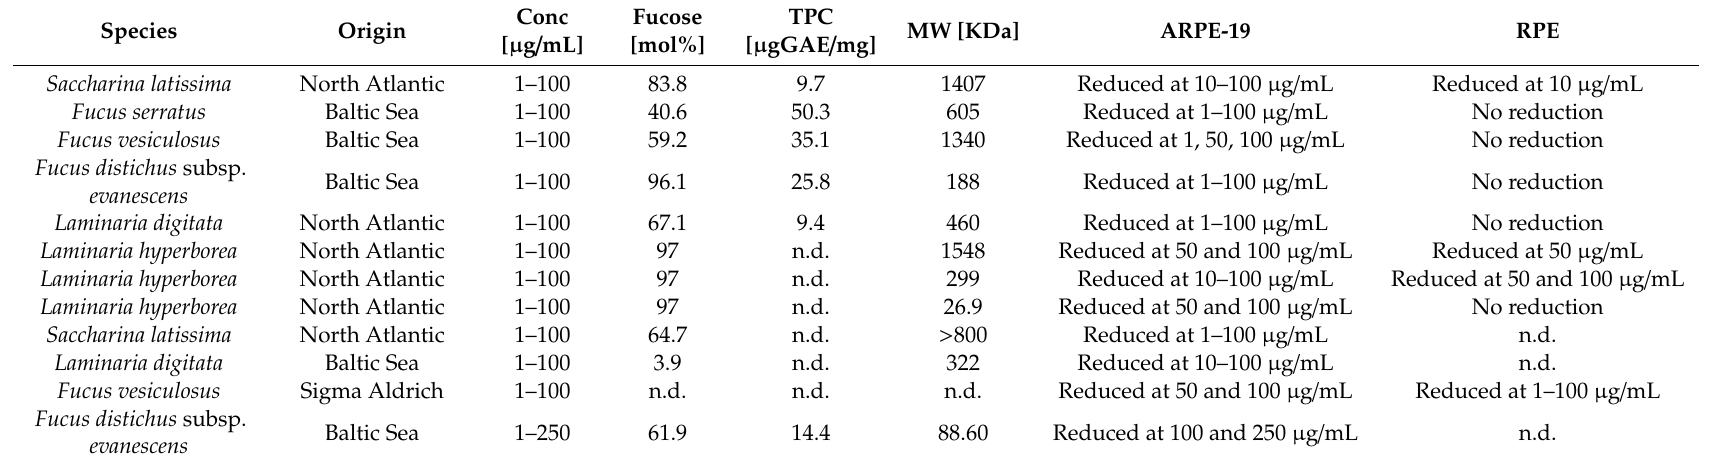
Table 1. List of tested fucoidans, VEGF